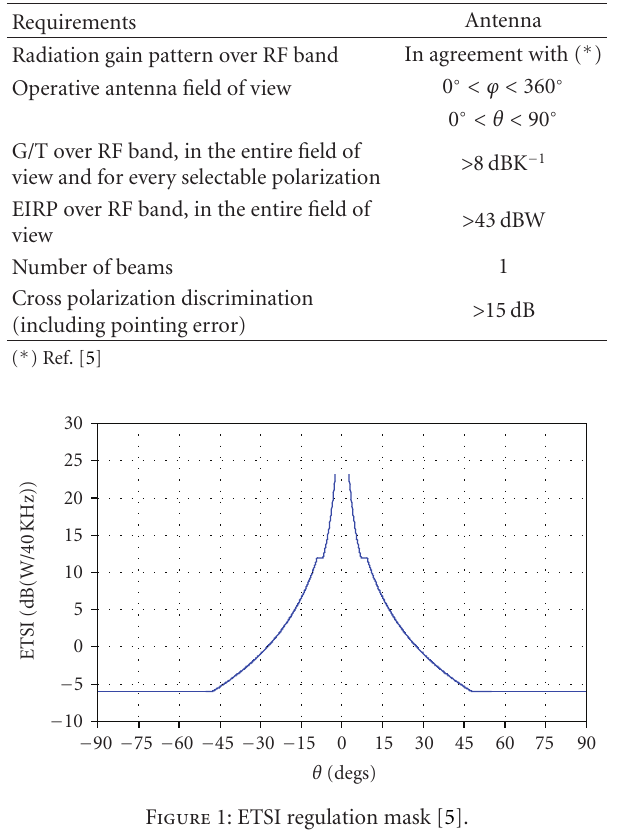
Table 1: Antenna performances requirements.